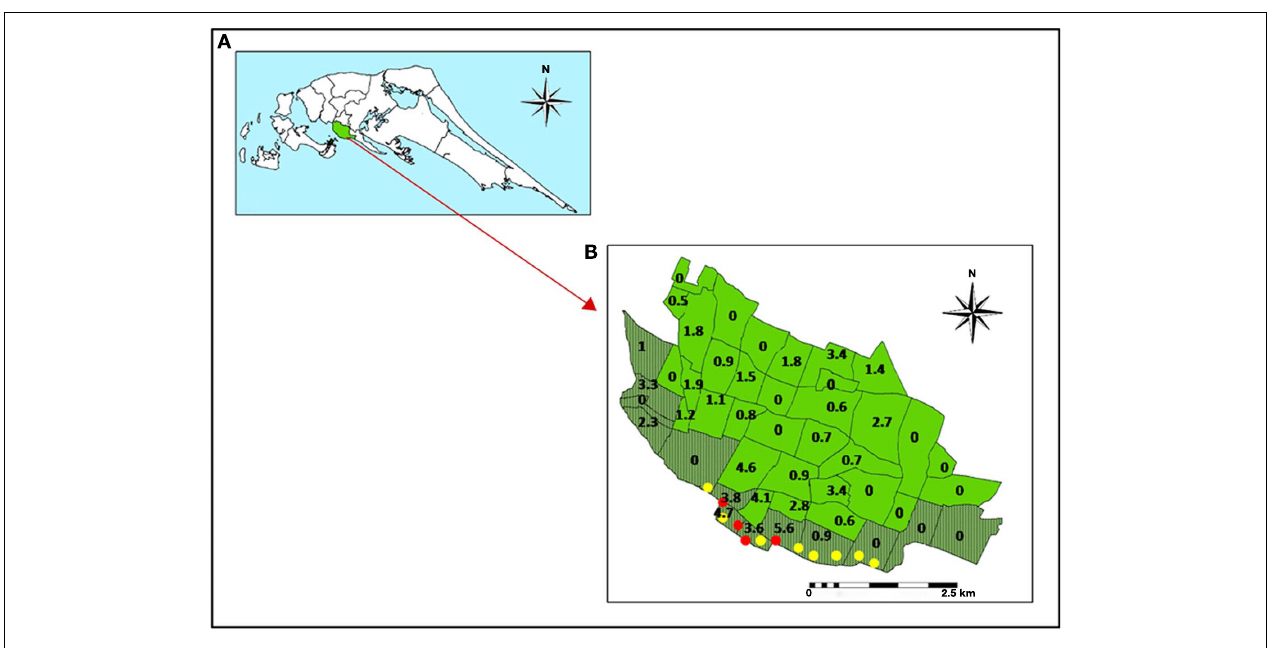
7months October 2010 to April 2011 in each division. Red and yellow filled circles show brackish water sites along the Jaffna coastal area that were respectively positive and negative for Ae. aegypti larvae. Each circle had one or more container, well or boat that was sampled (reproduced with permission from Ramasamy et al.,